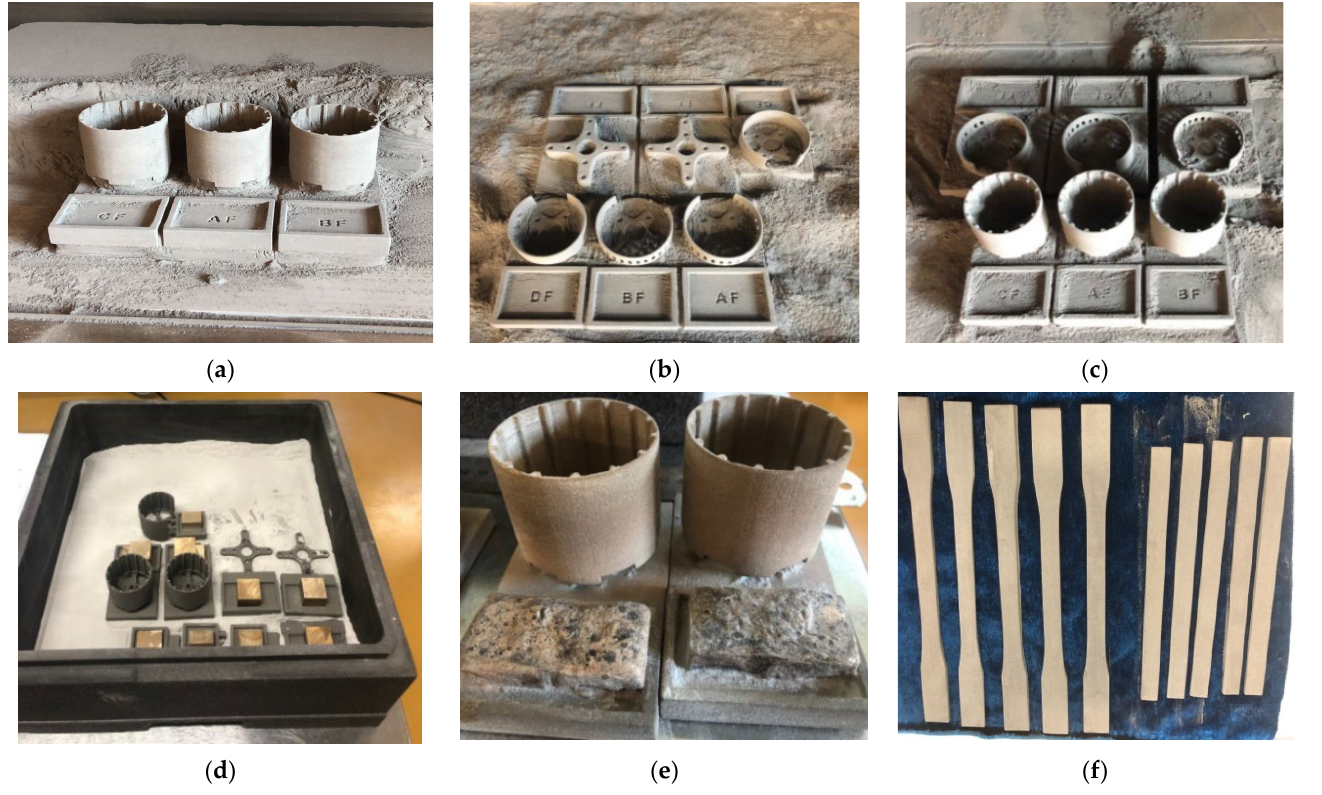
Figure 2. Additive manufacturing of BLDC motor components using the SLS process: ( a ) Parts cleaning; ( b ) left housing and motor mount; ( c ) rotor; ( d ) preparing the components for infiltration into the sintering furnace; ( e ) rotor obtained after infiltration; ( f ) specimens obtained after infiltration.